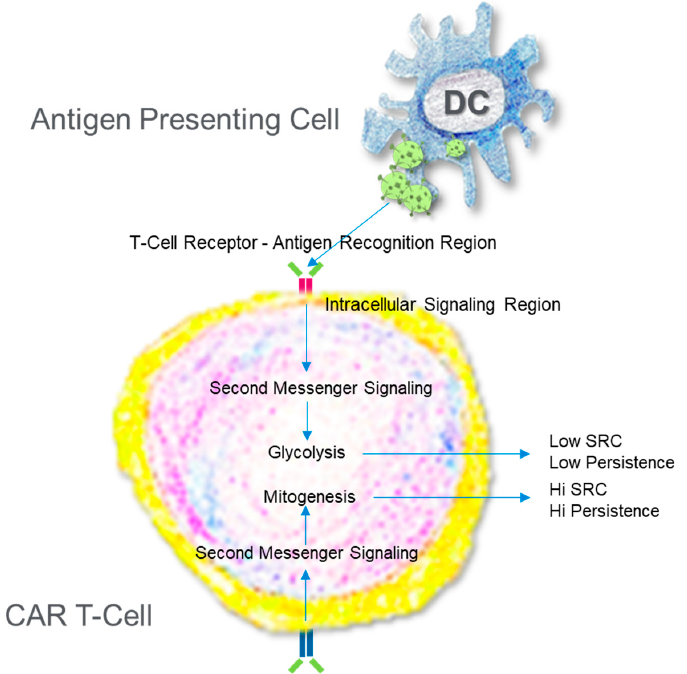
Figure 3. Engineering a Chimeric Antigen Receptor T Cell. T Cells are collected from individuals and then reprogrammed via gene editing to improve the sensitivity to antigen and promote the production of ATP. The path chosen to increase ATP production beyond what a normal activated T cell can do dictates the